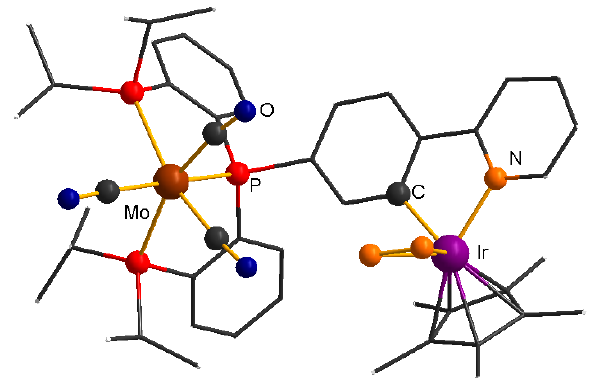
Figure 3. Molecular structure of a derivative of complex C1 in which the coordinated MeCN has been replaced by N 2 during crystallization. The non-coordinating PF 6 − counterion, all non-coordinating solvent molecules and hydrogen atoms have been omitted for clarity. All non-coordinating carbon atoms and Cp* are drawn as wireframe.